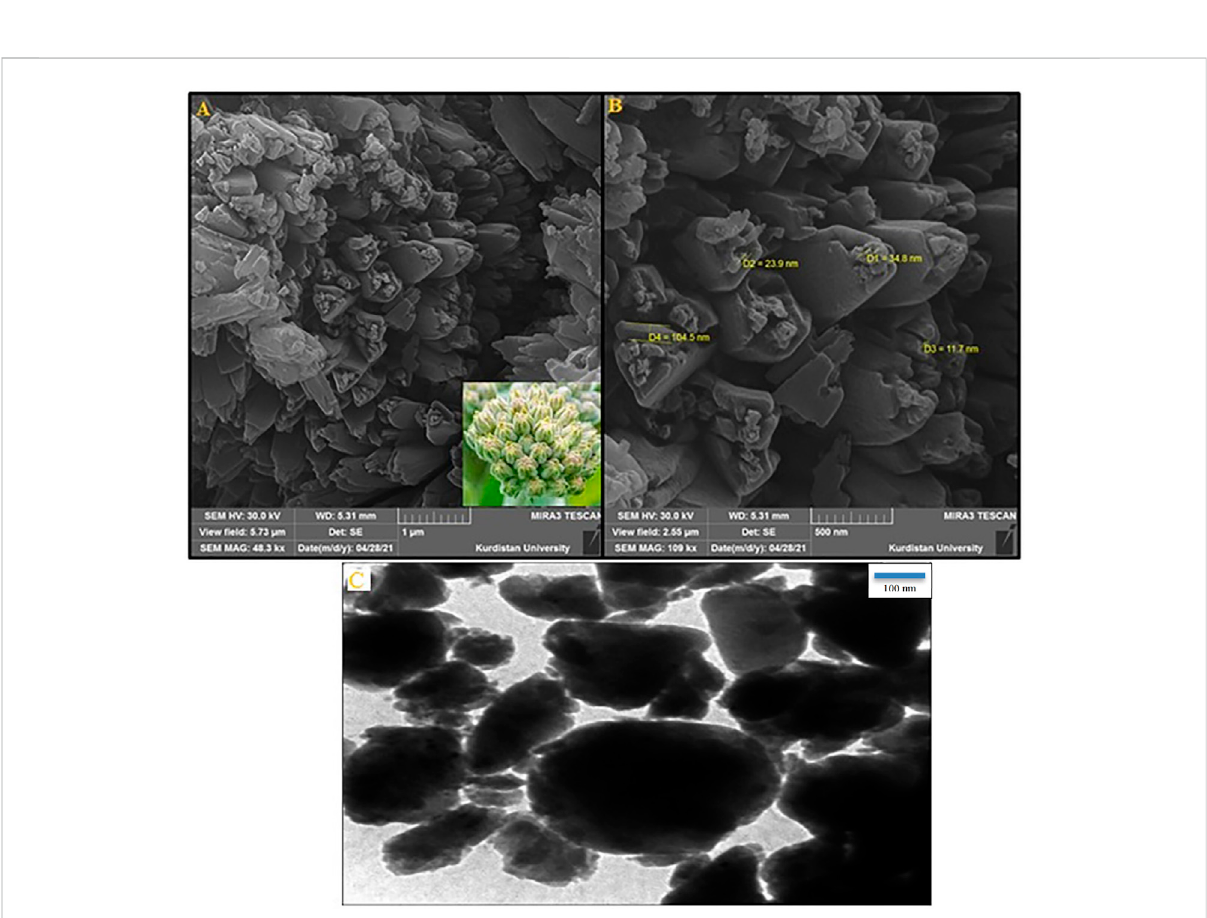
FIGURE 1 (A) FE-SEM image, (B) high-resolution FE-SEM image, and (C) TEM image of the CB Fe-hydroxyquinoline@Fe 3 O 4 NFC. Inset: digital image of cluster bud ‘ fl ower ’